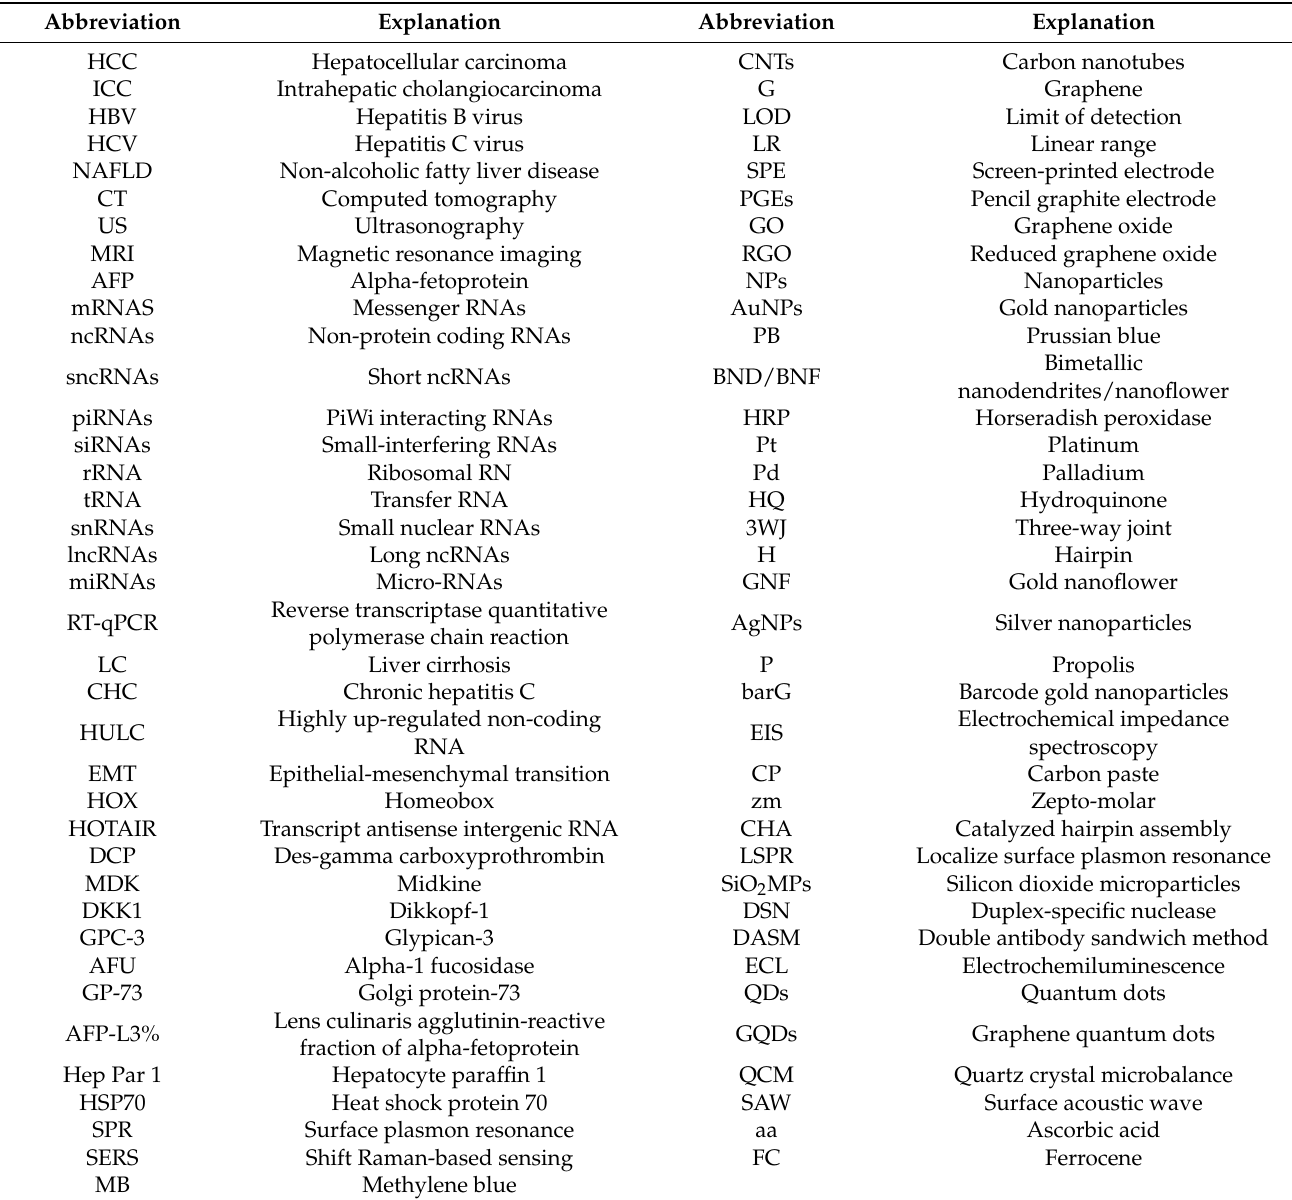
Table 4. List of abbreviations used in this